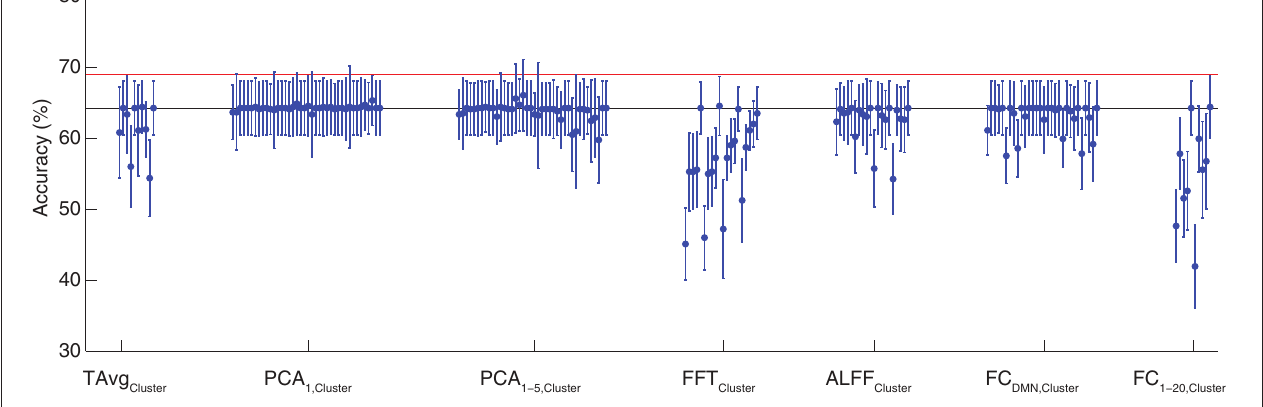
FIGURE 3 | Top: Accuracies on the binary diagnosis task (controls vs. ADHD) using features derived from clusters of significant difference on group comparisons (section 2.6) with five different classifiers (section 2.2). Each blue dot with error bars shows the mean accuracy and standard deviation for one Diagnostic Pipeline (feature data and classifier combination) on 10-fold cross validation with the 668 participant Training Dataset. The black horizontal line at 64.2% accuracy indicates chance baseline (guessing healthy control for all participants). The red horizontal